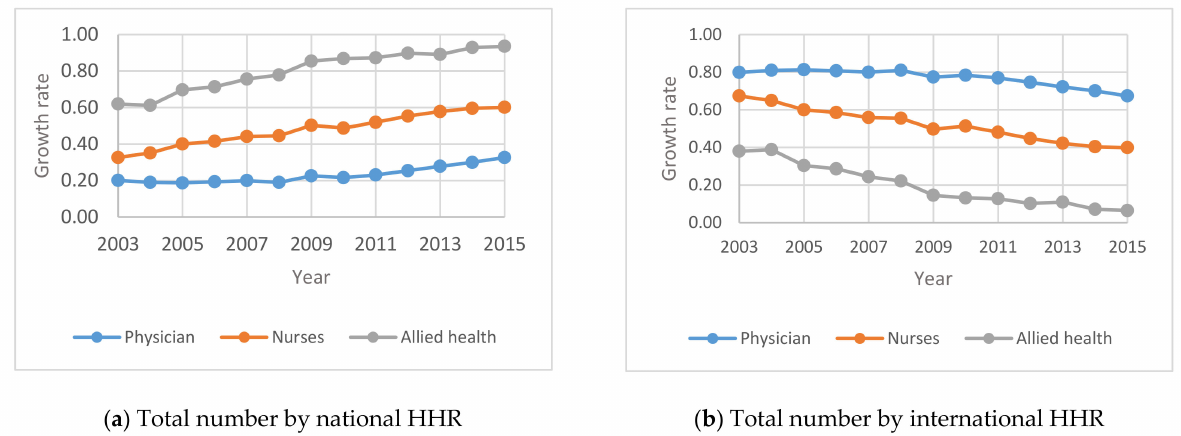
Figure 2. Annual Percentage change of national and international HHR in the MOH between 2003 and 2015: ( a ) total number by national HHR; ( b ) total number by international